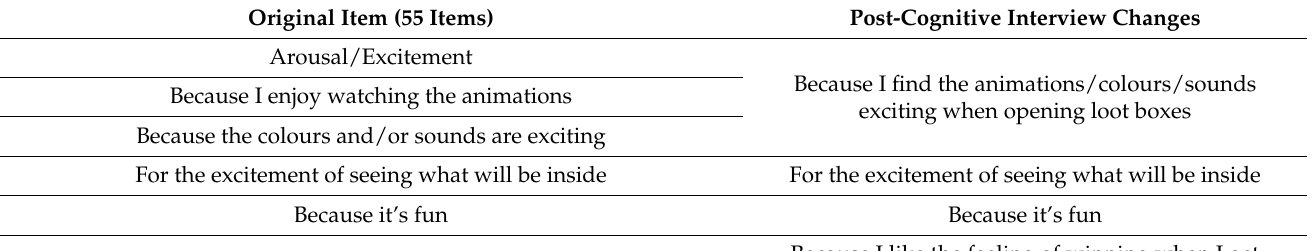
Table 1. Summary of original pool of candidate items before cognitive interviews (left) and streamlined pool of items after cognitive interviews